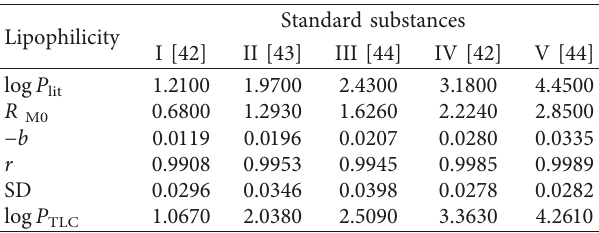
Table 1: Values of log P lit parameters, experimentally determined R M0 , and log P TLC for reference substances I – V . Lipophilicity